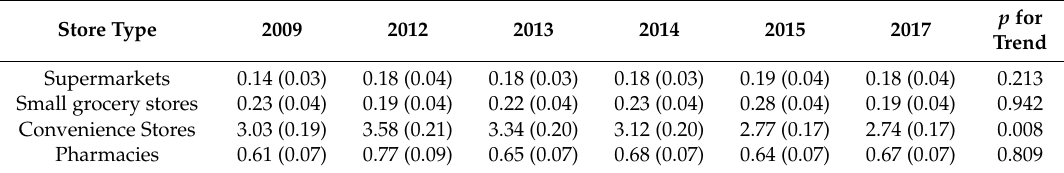
Table 2. Number of stores per census tract—mean (standard error) a